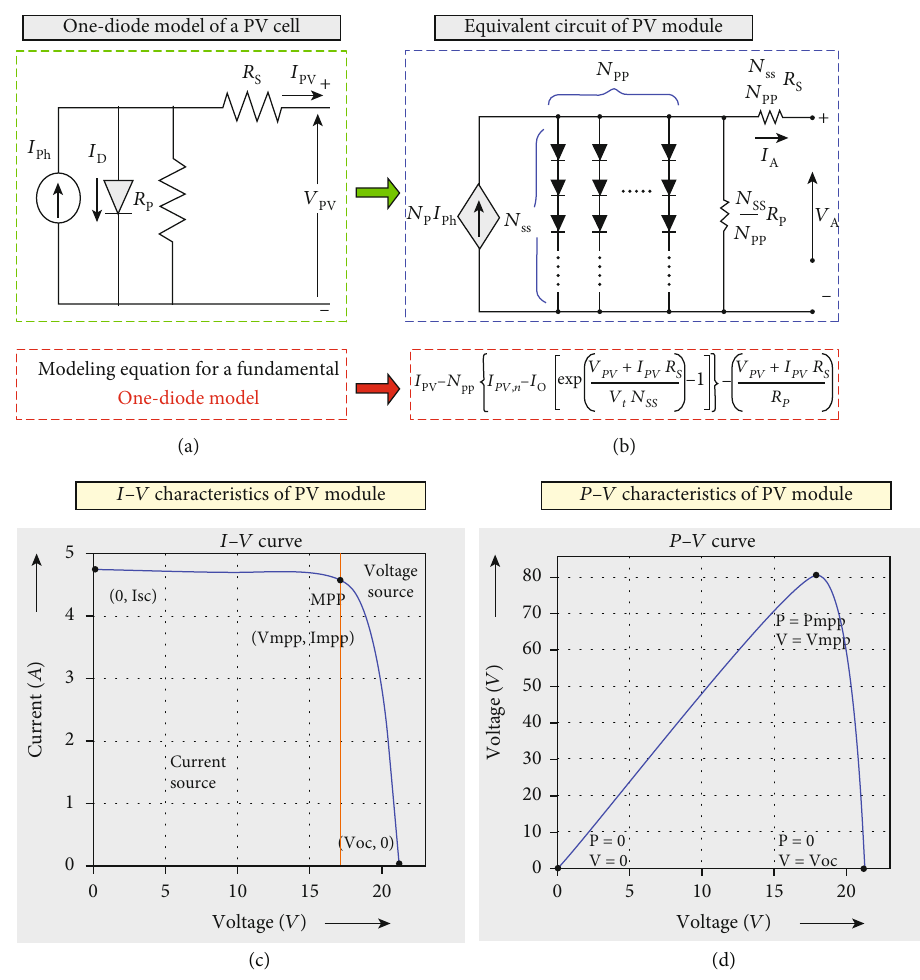
Figure 1: One-diode PV model and its